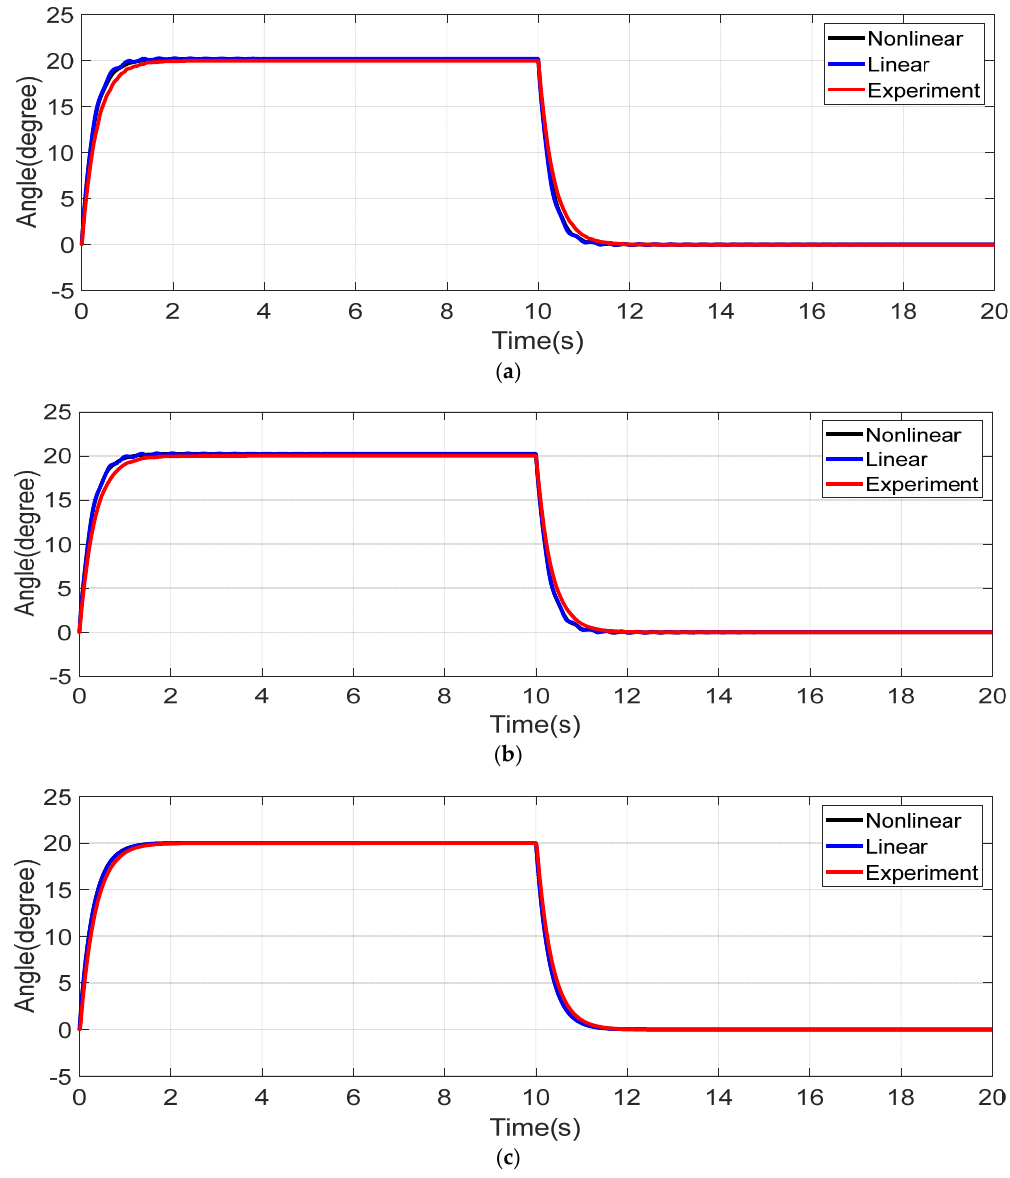
Figure 5. Validation of linearized model from joint angles. ( a ) Joint 1, ( b ) Joint 2, ( c ) Joint 3.